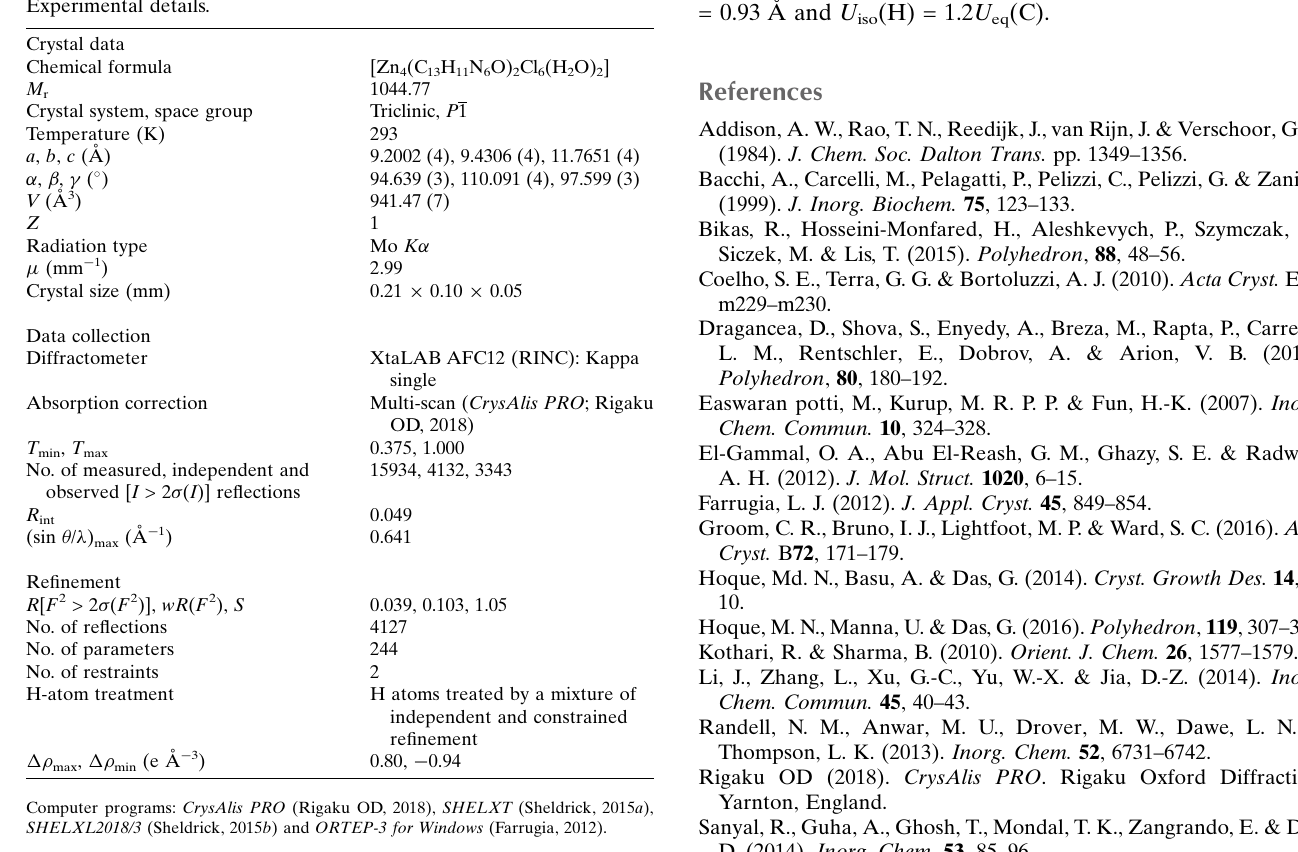
After two weeks, yellow crystals suitable for X-ray diffraction were collected, yield 87.9%. Analysis calculated for